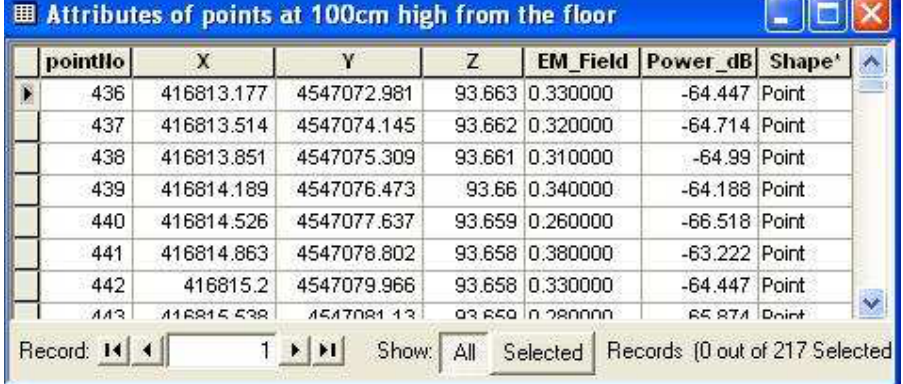
Figure 3. Attribute table of the points at 100 cm high from the floor; electromagnetic field values (V/m) are in the column “EM_Field” and power values (dB) are in the column